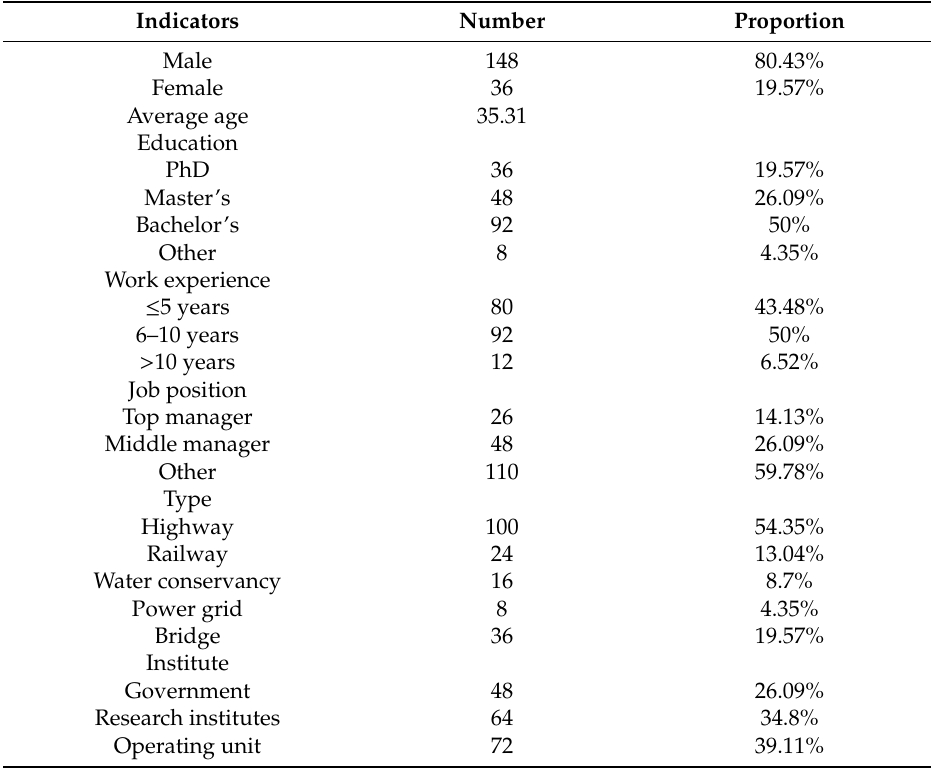
Table 5. Summary of the statistics of the interviewees.